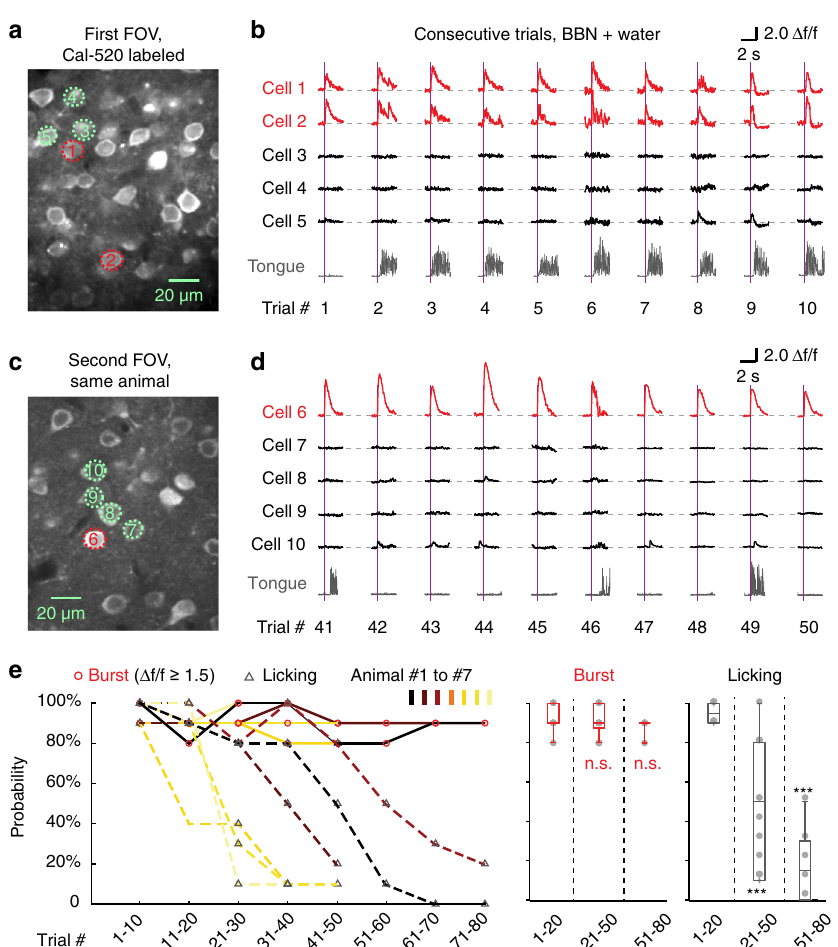
Fig. 5 Trial-by-trial analysis of sound-evoked bursting response and licking behaviour. a First imaging FOV in a head- fi xed mouse in a testing session of sound-evoked licking behaviour. b Sound-evoked Ca 2 + responses (upper) from the cells outlined with dashed circles in ( a ) and corresponding licking action traces (lower, grey traces). c , d The same arrangement as in a and b , obtained at the second imaging FOV during the same experiment session, with the cumulative trial index counting from 41. e Left graph, scatter plot shows the bursting response probabilities (red circles) and the sound-evoked licking rates (grey triangles) with respect to the trial index range. Datapoints are collected from n = 7 mice, and the licking probability data points are connected by coloured dashed lines to indicate each individual animal. Middle and right boxplots, summary of bursting response probabilities (red boxplots) and licking rates (grey boxplots) for the same datapoints on the left graph. Middle: P = 1.00 (1 – 20 versus 21 – 50), P = 0.34 (1 – 20 vs. 51 – 80), two-sided Wilcoxon rank-sum test, Bonferroni corrected, Burst n = 14, 17, 6 events, respectively; Right: P = 2.44e − 5 (1 – 20 vs. 21 – 50), P = 6.92e − 4 (1 – 20 vs. 51 – 80), two-sided Wilcoxon rank-sum test, Bonferroni corrected, Licking n = 14, 17, 6 events, respectively; n.s., P > 0.05, *** P < 0.001. Boxes represent Q1 and Q3, central bars indicate the median, and whiskers indicate Q1-1.5 × IQR and Q3 + 1.5 ×